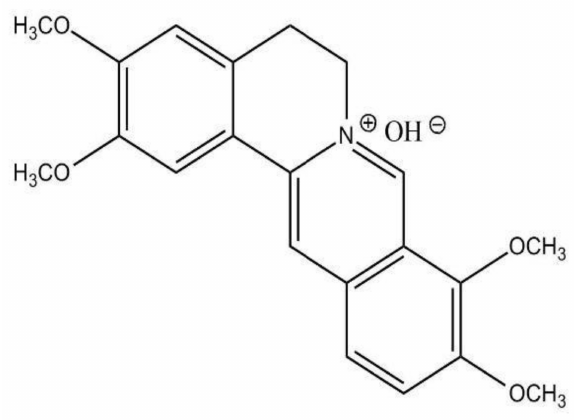
Figure 5. Chemical structure of palmatine.